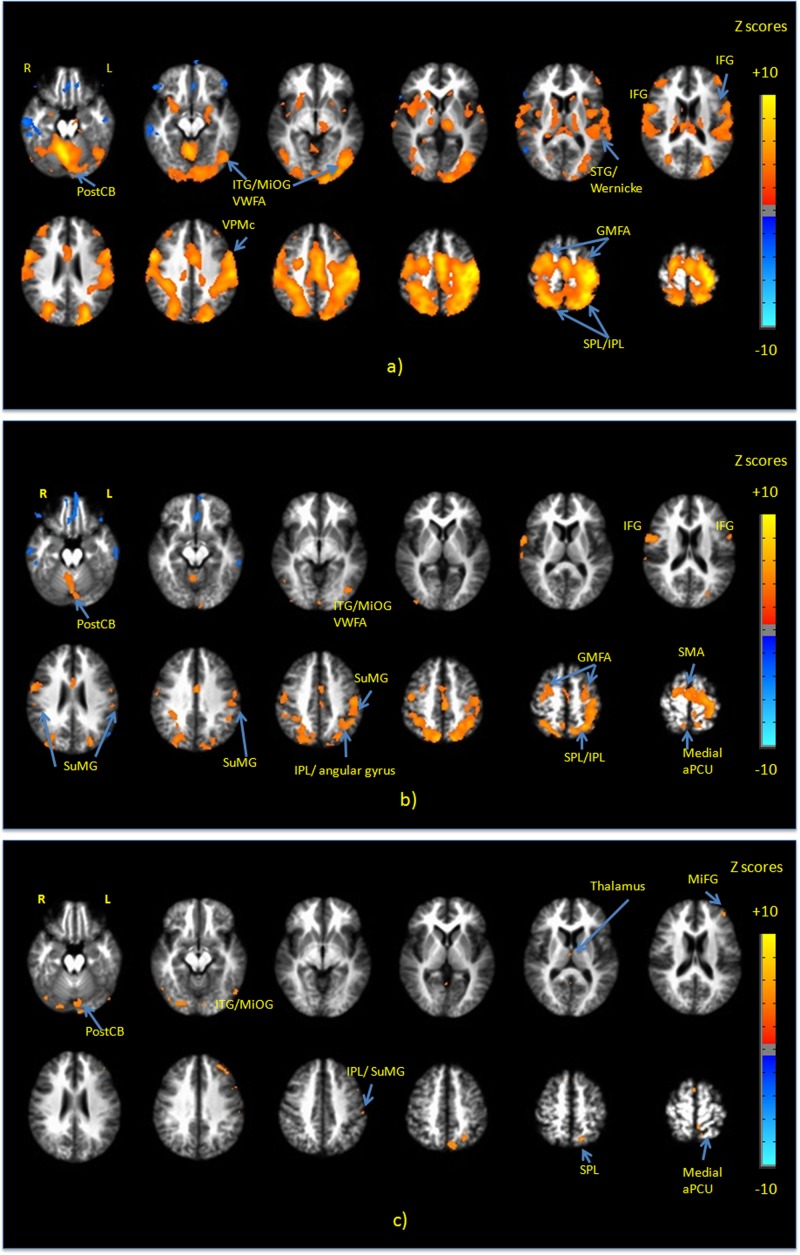
Activation maps of the first principal component (PC1) for (a) all handwriting tasks vs. baseline; (b) copying a sentence vs. copying phone numbers; and (c) copying a sentence vs. copying a grocery list. All activations are thresholded at the false discovery rate of q = 0.01. Activation maps were not statistically significant for any other principal components. IFG, inferior frontal gyrus; MiFG, middle frontal gyrus; STG, superior temporal gyrus; ITG, inferior temporal gyrus; MiOG, middle occipital gyrus; IPL, inferior parietal lobule; SPL, superior parietal lobule; SMA, supplementary motor area; PostCB, posterior cerebellum; VWFA, visual word form area; aPCU, anterior precuneus; GMFA, graphomotor frontal area; SuMG, supramarginal gyrus.